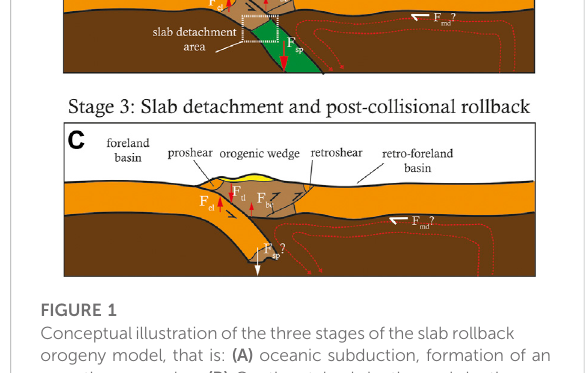
FIGURE 1 Conceptualillustrationofthethreestagesoftheslabrollback orogeny model, that is: (A) oceanic subduction, formation of an accretionary wedge. (B) Continental subduction, subduction slowdown ultimately leading to slab detachment. (C) Slab detachment followed by slab rebound, post-collisional slab rollback, and trench shift towards the foreland. General mantle fl ow patterns are drawn in red. Arrows are not to scale. Symbols: F sp : slab pull, F el : elastic bending resistance, F tl : topographic gravitational loading, F bc : buoyancy force of the light crustal root, F md : mantle drag beneath the overriding